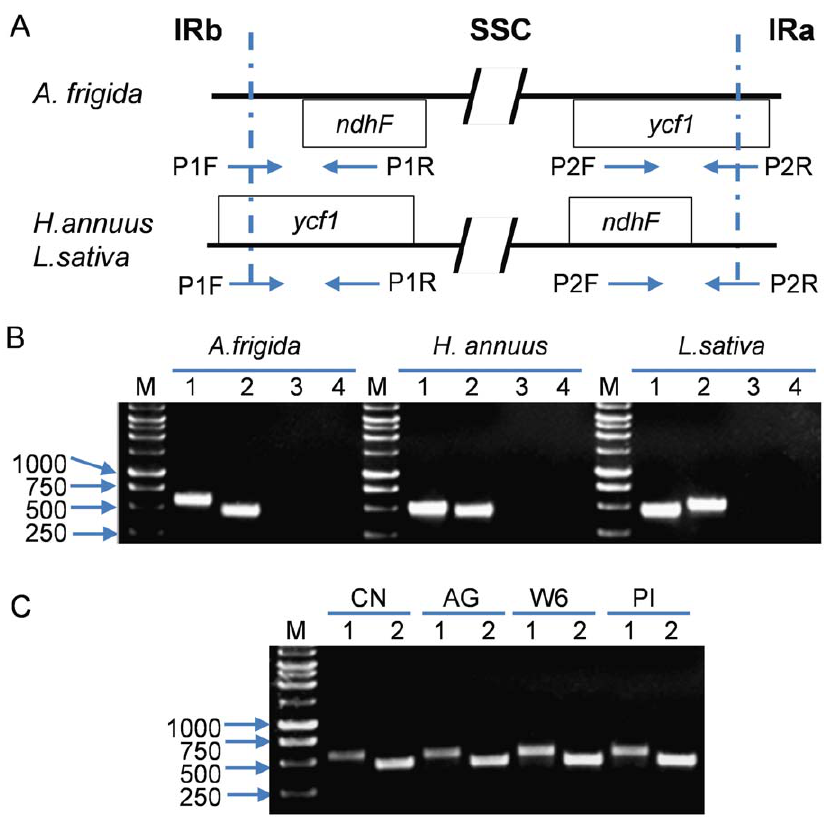
Figure 4. Analyses of SSC inversions in the Asteraceae family. A. Primer design to amplify junction regions between IR and SSC regions. The positions of ndhF and ycf1 genes in relation to IRa and IRb regions are drawn based on the sequence assembly results of A. frigida in this study and H. annuus and L. sativa from published data [38]. To design primers that amplify the junction region between IRa and left border of the SSC, the forward primer P1F contains the sequence with half of length from IRb and the other half from the SSC region. The sequence of the reverse primer (P1R) is located in the ndhF gene. The same strategy was employed in primer design to amplify the other junction region between ycf1 and IRa regions as indicated. The same strategy was also used to examine the junctions in H. annuus and L. sativa based on their assembled sequences as indicated in the diagram. B. PCR amplification of IR and SSC junction regions in Artemisia frigida, Helianthus annuus and Lactuca sativa. M:Promega 1 kb ladder; lane 1, primer pair P1F and P1R, lane 2, primer pair P2F and P2R, lane 3, primer pair P1F and P2F, and lane 4, primer pair P1R and P2R. C. PCR amplification of IR and SSC junction regions in different accessions of Artemisia frigida . Four Artemisia frigida accessions were used in PCR reactions; CN: cp sequenced accession in this study and originated from China, AG:AG258 from Alaska, USA, W6: W6 30042 from Colorado, USA, and PI: PI 639180 from Mongolia. Lane 1, primer pair P1F and P1R, Lane 2, primer pair P2F and P2R.